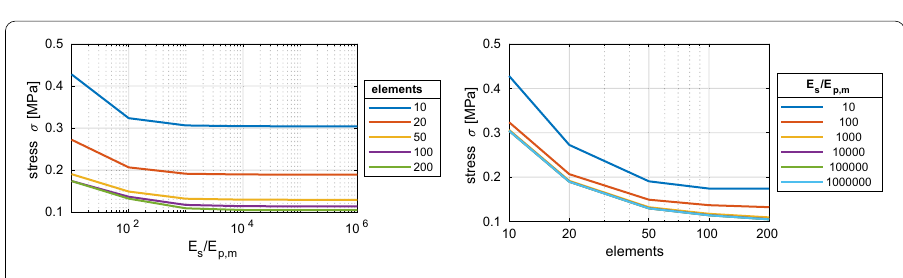
Fig. 8 Convergence of the final stress in a constrained bar subject to a moving peak temperature load. Convergence is influenced by the number of (finite) elements and the stiffness ratio between solid and powder/melt. Both diagrams contain the same information in different representations